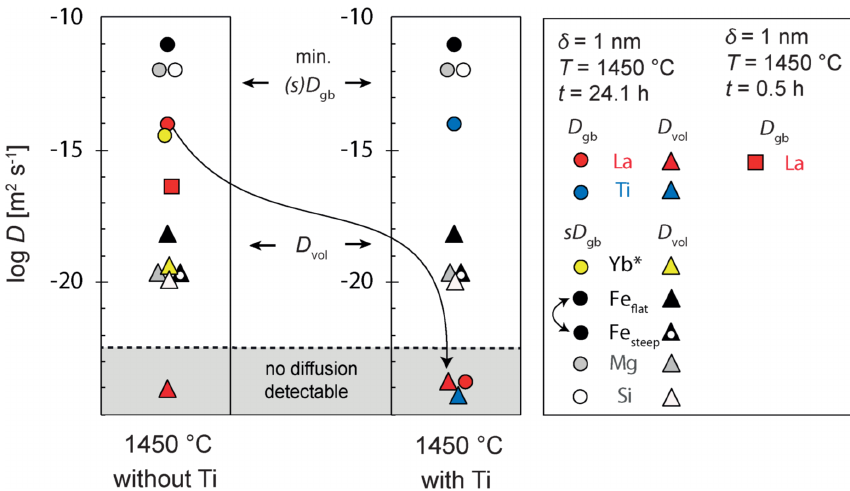
Figure 10. D vol and sD gb results at 1450 ◦ C. Results from sample TH_9_2 and TH_9_3 are indicated with dots ( sD gb and D gb ) and triangles ( D vol ). The result from the short experiment (sample TH_9_5) is indicated with a square. For La and Ti, we could directly obtain D gb independent of s and δ because a type-C regime was assumed. sD gb of Fe 2 + and Fe 3 + are not distinguishable in the measured profiles. * Yb data are from Marquardt et al. (2011a). Yb has a comparable ionic radius as Y and does not segregate at the grain boundary ( s =